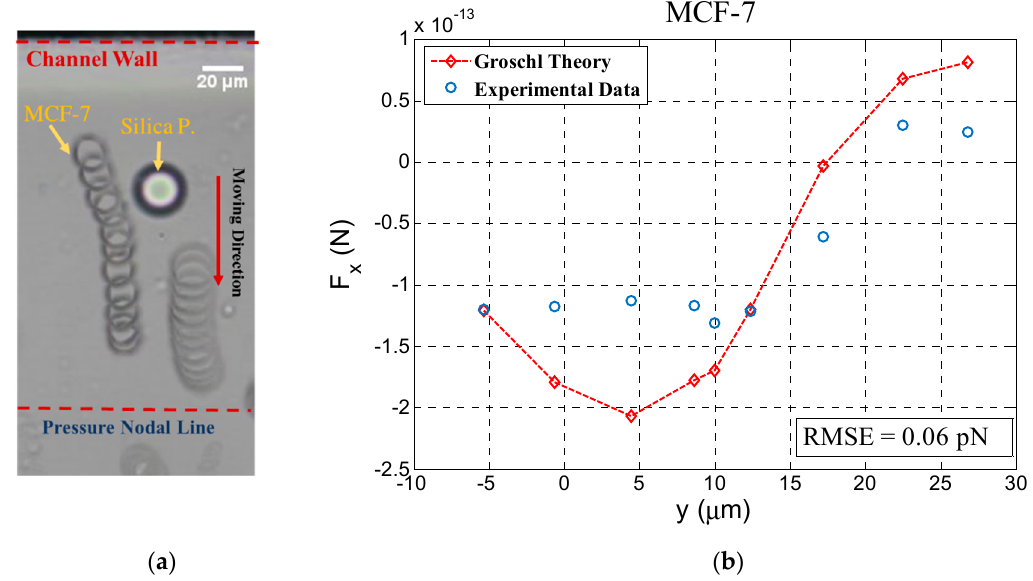
Figure 4. Time series of MCF-7 pathways while moving close to the fixed silica particle ( a ), and comparison of experimental data of the secondary acoustic force between a MCF-7 cell and silica particle with the extended Gröschl model ( b ). Here, the center of the fixed silica particle is located at 108 µm from the pressure nodal line.